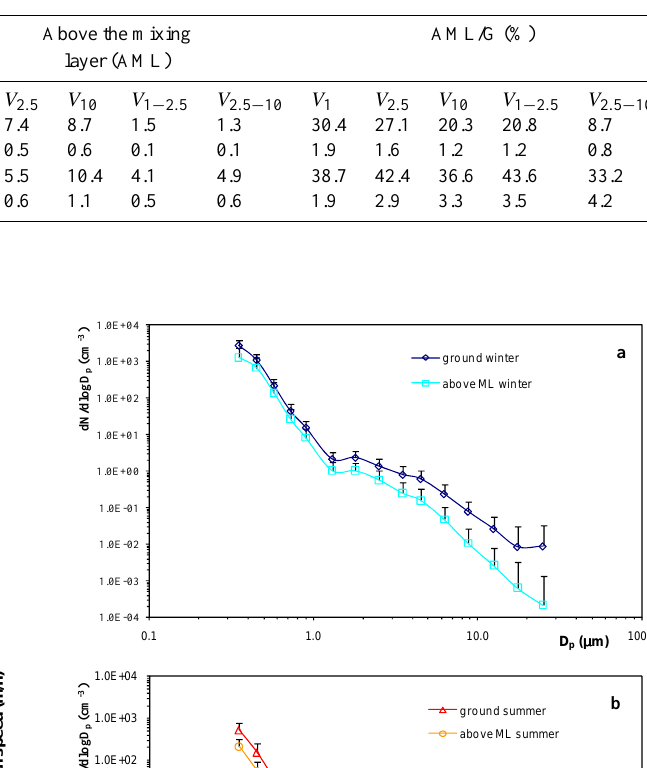
Table 1. Aerosol volume concentration (mean and mean standard deviation σ m ) at ground-level (G), above the mixing layer (AML) and the ratio between the two. Data were collected in winter (DJF months; N profiles=142) and in summer (JJA months; N profiles=72). V 1 , V 2 . 5 , V 10 and their in-between V 1 − 2 . 5 and V 2 . 5 − 10 are calculated considering particle smaller than 1µm, 2.5µm, 10µm and in the ranges 1–2.5µm and 2.5–10µm. Concentrations measured above the mixing layer are normalized to ground pressure and temperature.